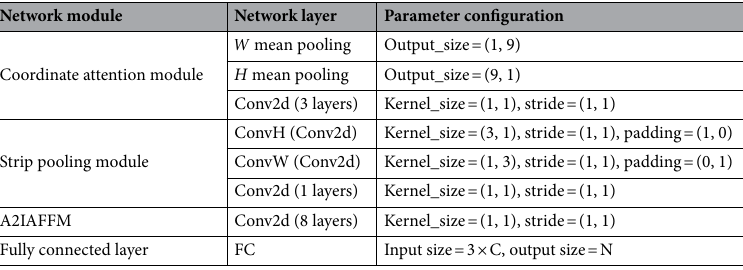
Table 1. Parameter configuration of the proposed